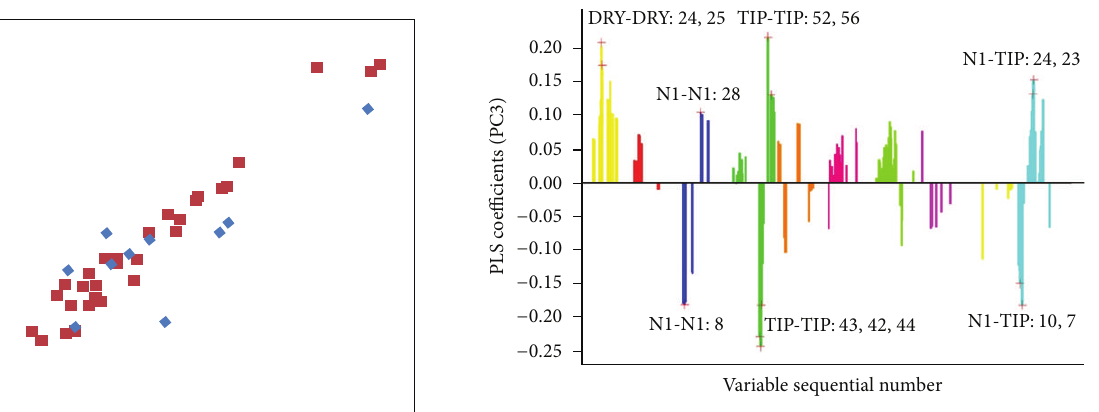
Figure 2: PLS coefficient plots for 3D-QSAR model. Direct and reverse correlation with the activity are indicated with positive and negative PLS coefficients, respectively. Bars with the most intensive height in the PLS plots have the most profound impact on the model